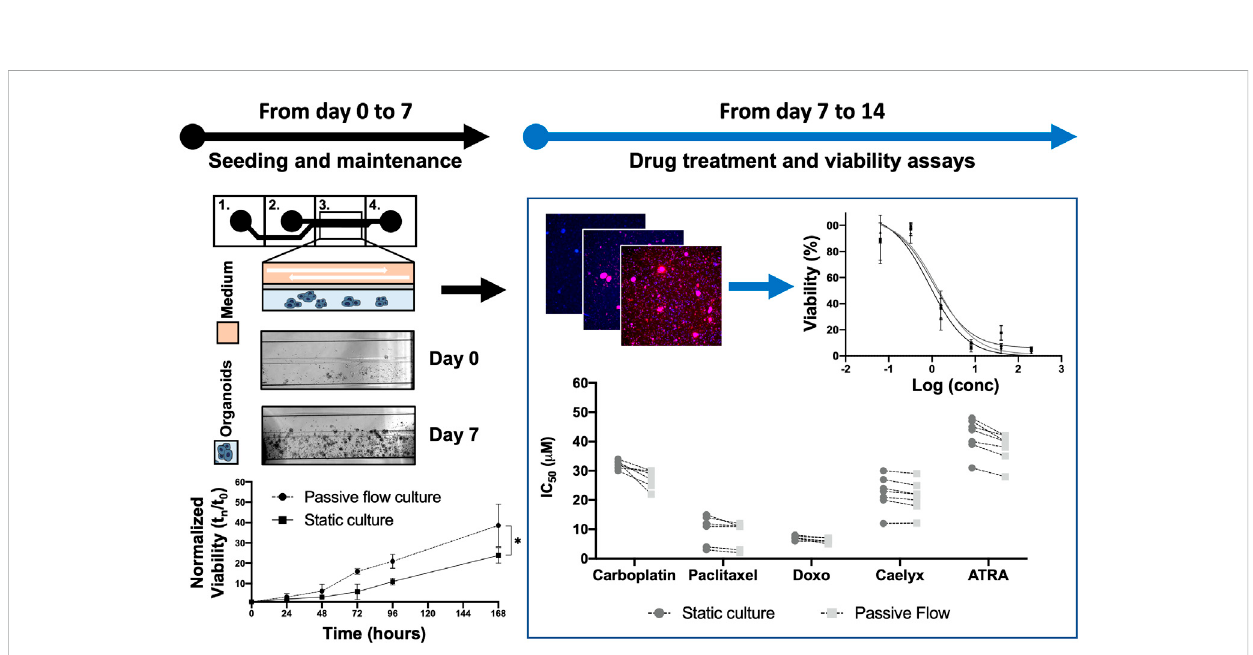
FIGURE 2 Flowchart: Previously, a protocol to cultivate the organoids in the Mimetas OrganoPlate ® 2-lane 96 was de fi ned. Organoids were seeded both in Mimetas and in 96-wells plates (day 0) and were maintained in culture for 7 days (day 7). The viability was measured every day for 7 days and the growth curve was established. After 1 week (day 7), the organoids were incubated with the drugs for 96 h. At the end of the incubation time, cell viability was measured (with ATP-based, Resazurin-based, and Fluorescence-based assays); the dose-response curve was established and IC 50 values were calculated (both in dynamic and static cultures). The p -value was calculated using two-way ANOVA, * p ≤